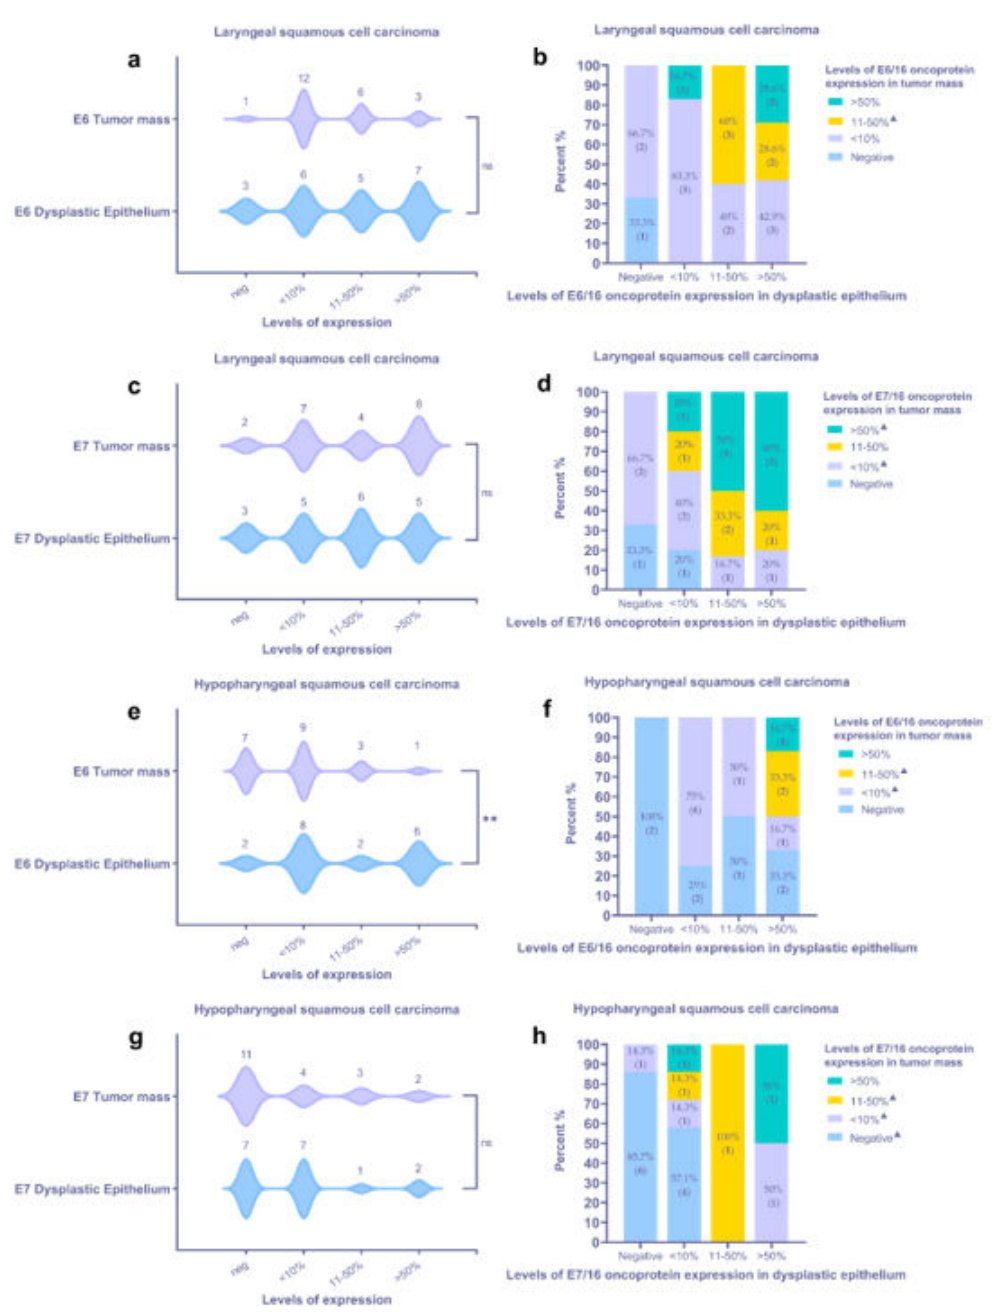
Figure 3. Assessment of viral oncoproteins E6 and E7 in HPV16+ laryngeal ( a – d ) and hypopharyngeal ( e – h ) tumor tissue samples using IHC and statistics: ( a,c ) characterization of HPV oncoprotein E6 ( a ) and E7 ( c ) immunoexpression within a tumor mass and dysplastic epithelium of LSCC samples; ( b , d ) the IHC expression levels for HPV oncoprotein E6 ( b ) and E7 ( d ) in a tumor mass assessed in relation to the levels in a dysplastic epithelium of the corresponding LSCC sample; ( e , g ) characterization of HPV oncoprotein E6 ( e ) and E7 ( g ) immunoexpression within a tumor mass and dysplastic epithelium of HPSCC samples; ( f , h ) the IHC expression levels for HPV oncoprotein E6 ( f ) and E7 ( h ) in a tumor mass assessed in relation to the levels in a dysplastic epithelium of the corresponding HPSCC sample. Violin plots: asterisks represent a significance level (ns—non-significant, * p < 0.05, ** p < 0.01) of differences between groups (two-tailed Wilcoxon test); (cid:78) stacked bar graphs—crosstab analysis, triangles ( ) represent a sample lacking an epithelial region suitable for assessment and, therefore, were excluded from crosstab